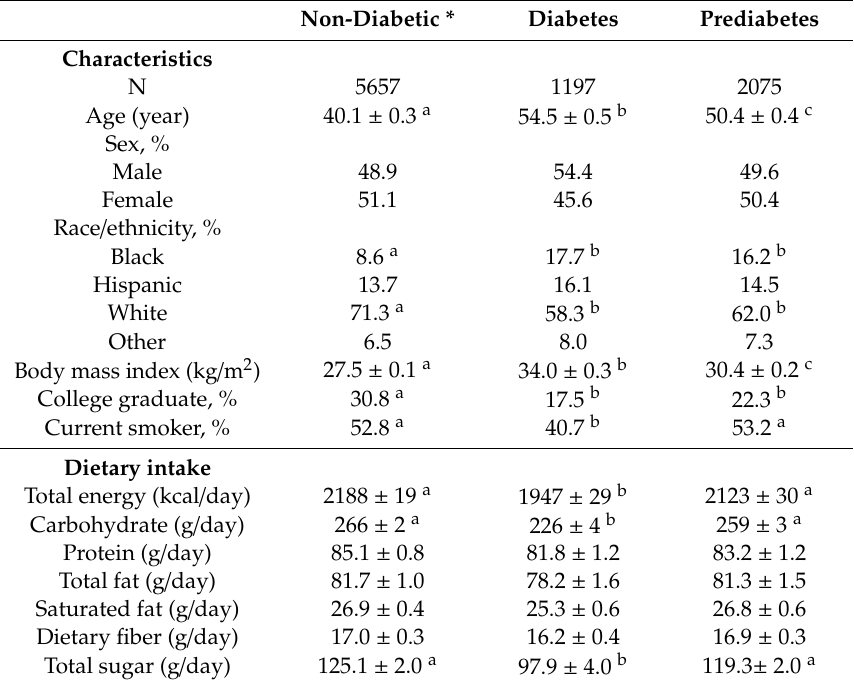
Table 1. Characteristics and dietary nutrient intake of study